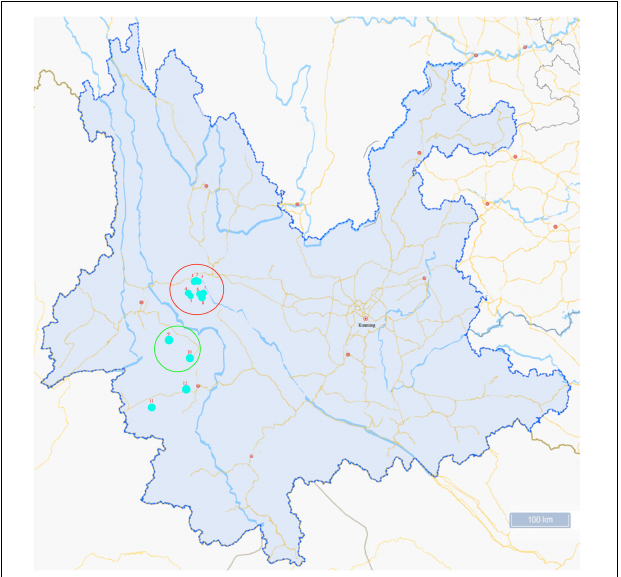
FIGURE 1 | Map of the sampling sites in Yunnan Province, China. Ticks collected were fed on cattle in Lincang city (sampling sites 1–8) and Weishan city (sampling sites 9–12). The colored circles indicate the two cities where the ticks were collected and the dots indicate the sampling regions in this